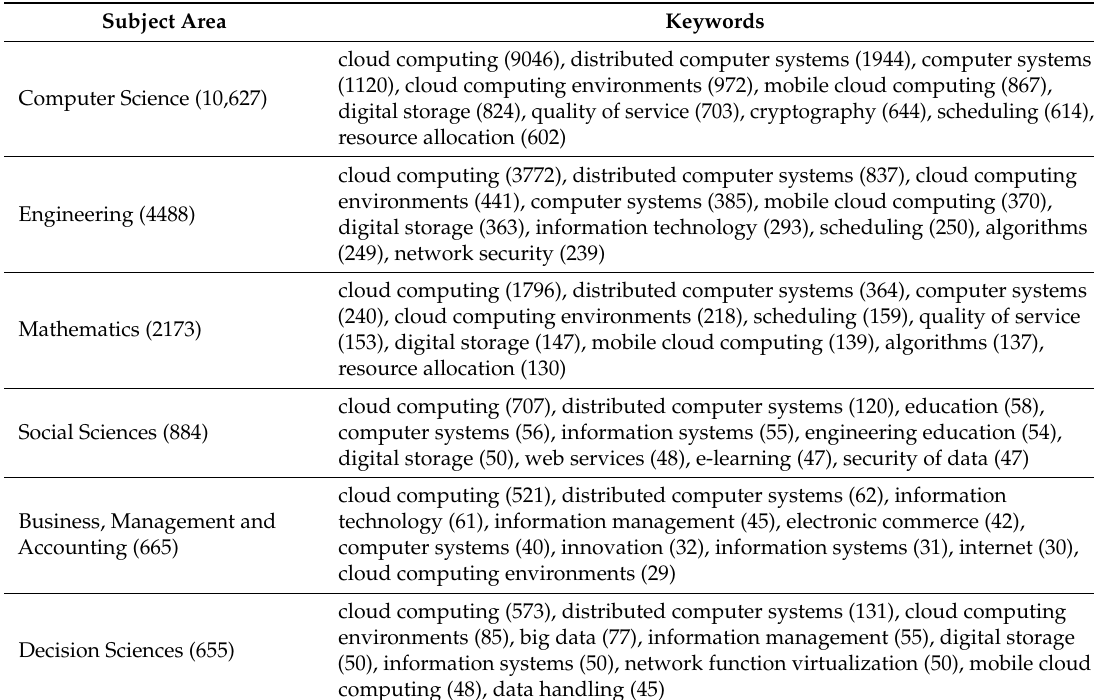
Table 10. Top most often cited keywords in research on cloud computing by a subject